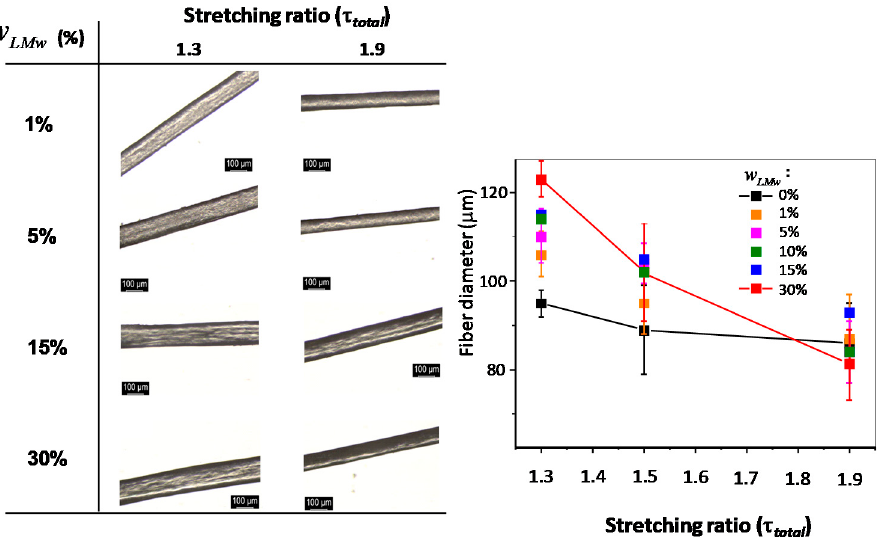
Figure 3. Optical microscopy images (left) and main diameter (right) of spun fibers processed with collodions containing different mass fractions of LMW chitosan w LMW , by using different total stretching ratios ( τ total ) of 1.3 and 1.9. Scale bar: 100 µ m. The photo on the top-right shows an example of fibers of w LMW = 5% collected on a take-up